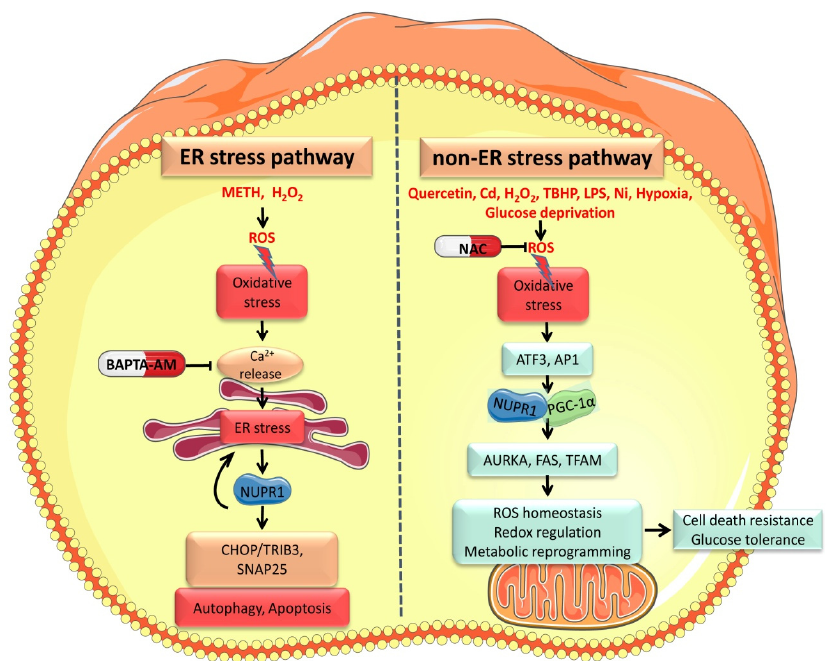
Figure 1. Oxidative stress activates NUPR1 by both ER stress (METH [11] and H 2 O 2 [40]) and non-ER stress pathways (Quercetin [31], Cd [34], H 2 O 2 [40,41], TBHP [42,43], LPS [44], Ni [45], hypoxia [46,47] and glucose deprivation [46–48].